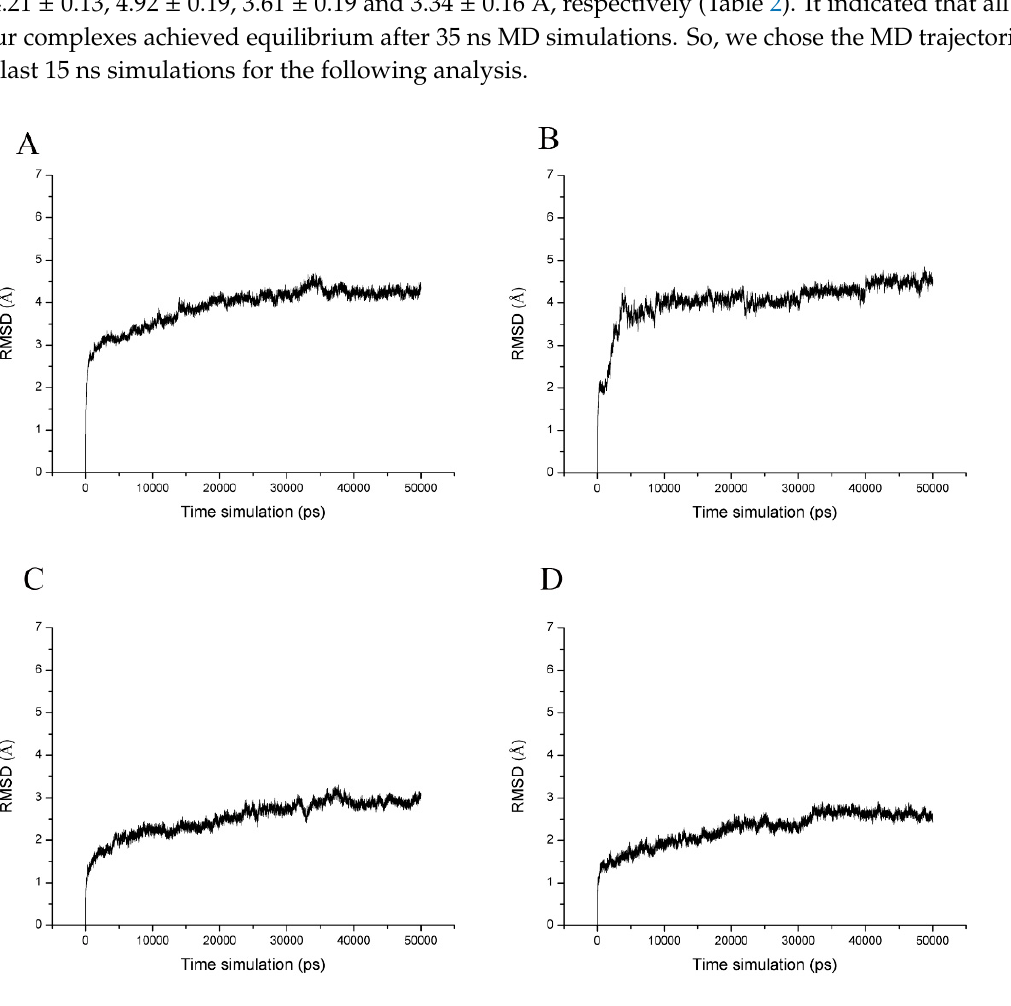
Figure 3. Time dependence of root mean square deviation (RMSD) of the backbone atoms (Ca, N, and C) for IaAS1_alpha ( A ), IaAS1_beta ( B ), IaAS2_alpha ( C ) and IaAS2_beta ( D ). The reference was the first snapshot of MD of each complex.